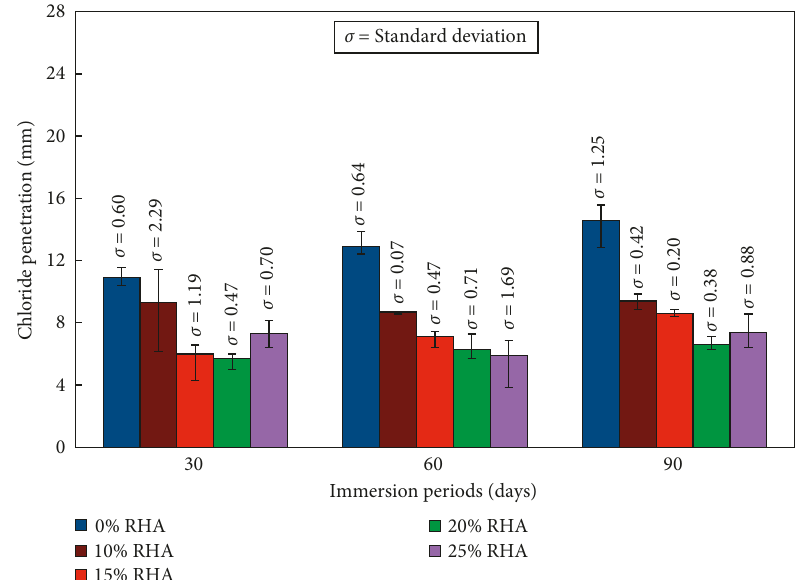
Figure 7: Chloride penetration of RBAC at 30, 60, and 90